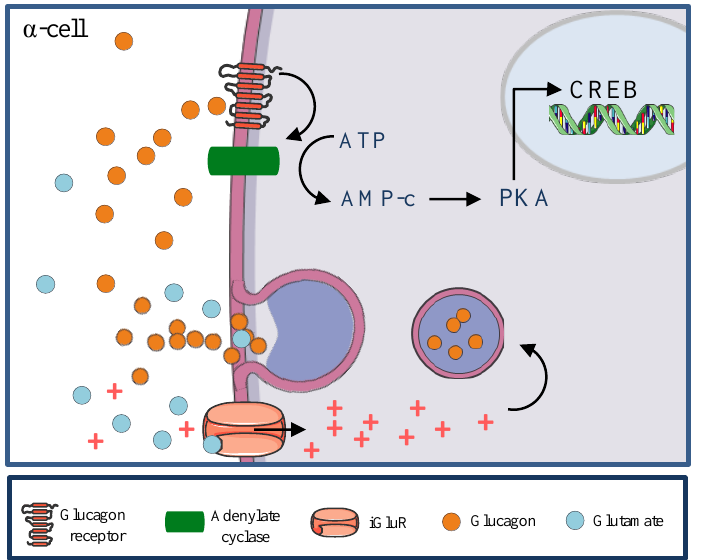
Figure 3. Autocrine regulation of glucagon secretion. In the α cell, GRs activation increases glucagon gene transcription via cAMP response element-binding (CREB). Glutamate is also present in α cell vesicles. It acts as a glucagon-secretion enhancer acting by ionotropic glutamate receptors (iGluR) stimulation or by binding other proteins like α -amino-3-hydroxy-5-methyl-4-isoxazolepropionic acid (AMPA) receptor and kainate receptors in the α cell membrane. Activation of iGluR drives to α cell depolarisation, activation of VGCA, and subsequent the fusion of glucagon-containing vesicles with cell